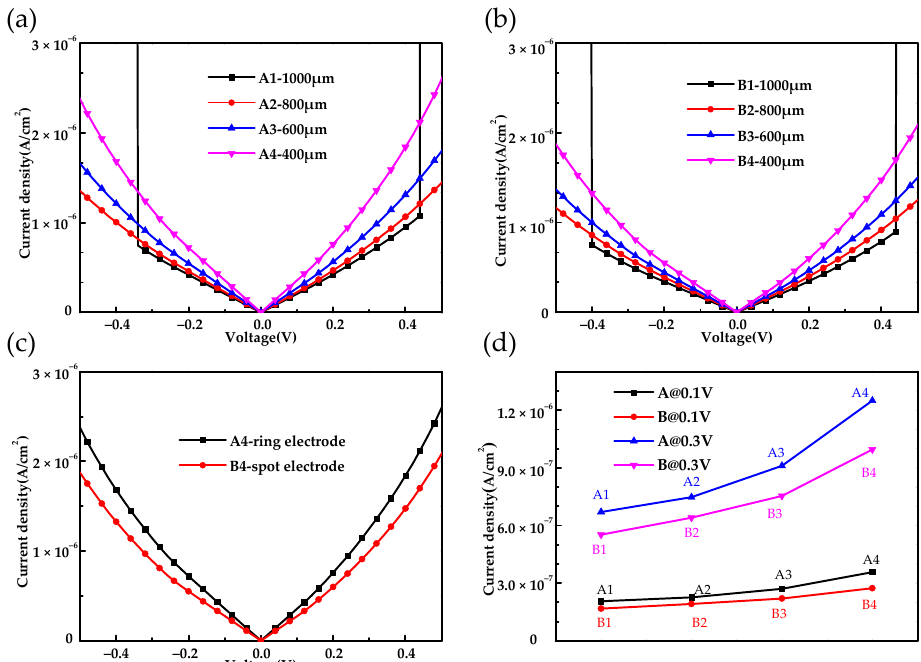
Figure 2. The dark current density-voltage characteristics of ( a ) A detectors and ( b ) B detectors. ( c ) Comparison of the dark current density-voltage of the A4 and B4 detectors. ( d ) The dark current density-voltage of the different detectors at 0.3 V and 0.5 V.